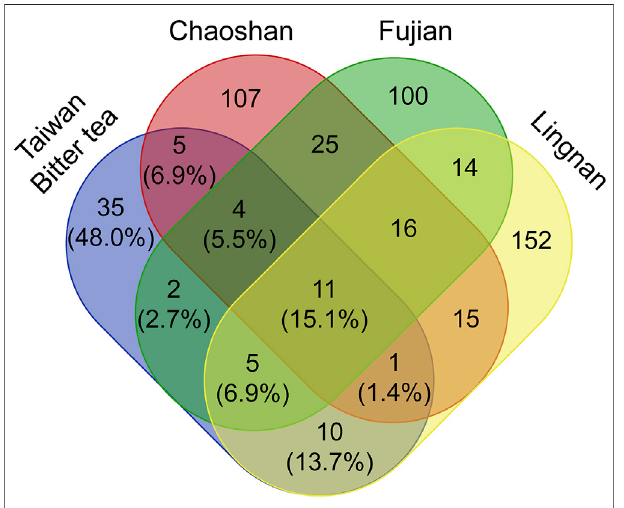
FIGURE5| Venndiagramshowingthenumberofsharedplantmaterials in herbal tea from different regions.